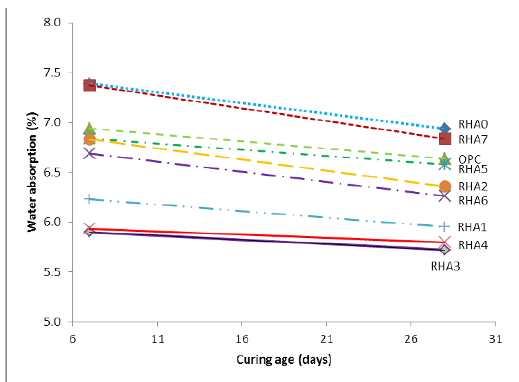
Figure 13. Water absorption of OPC and RHA at various grinding time and porous surface of rice husk